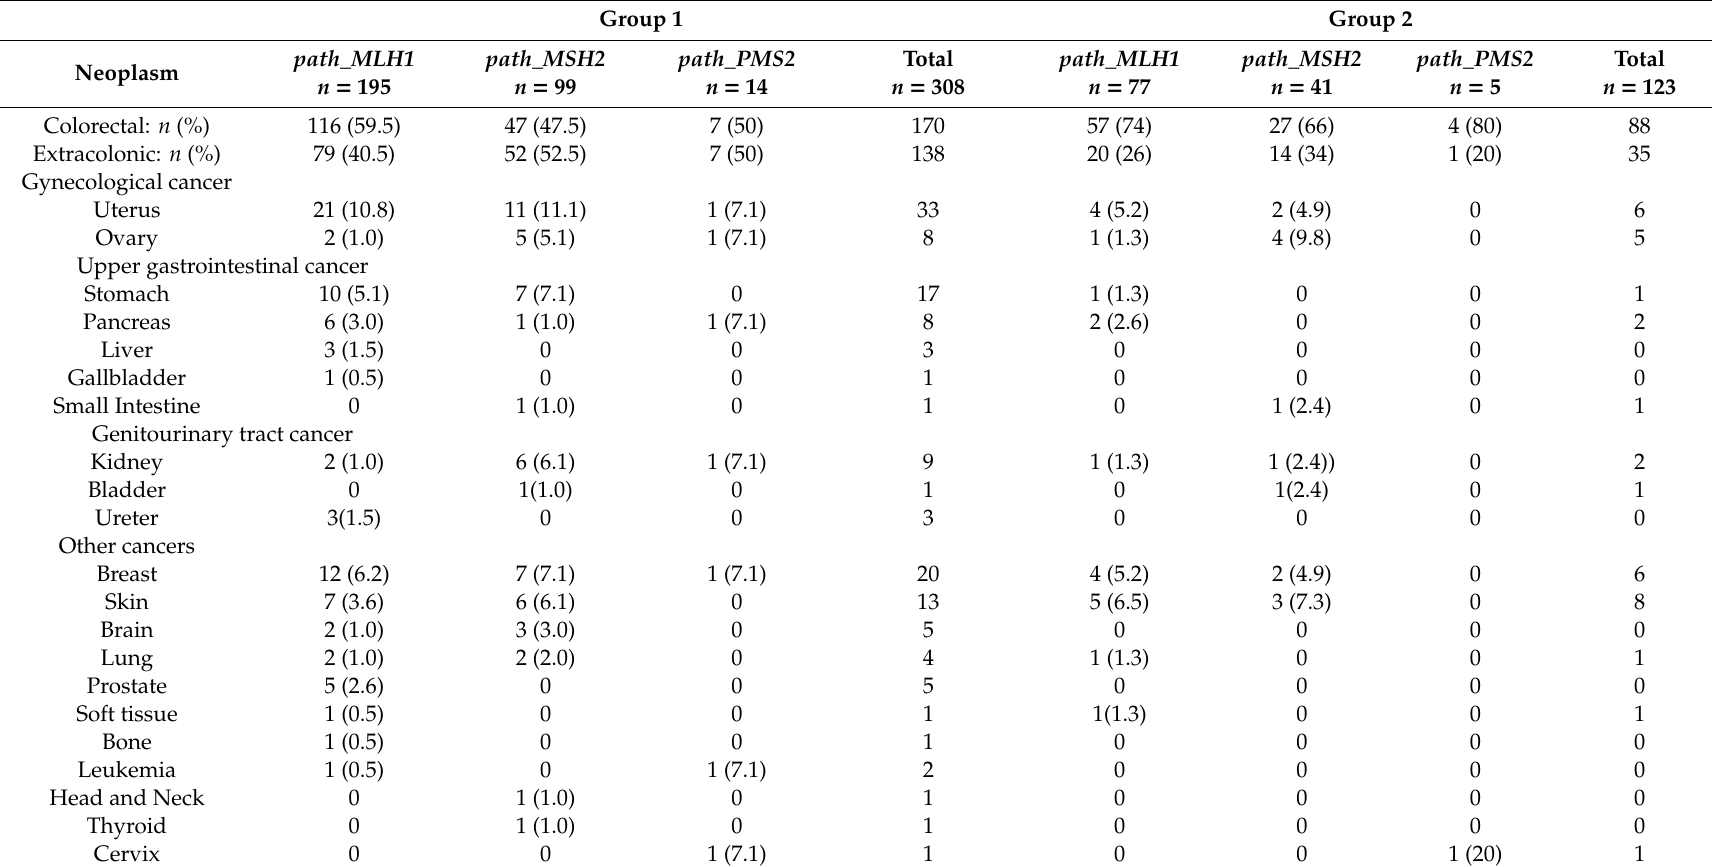
Table 3. Spectrum and frequency of neoplasms in Group 1 and Group 2 for each path_MMR